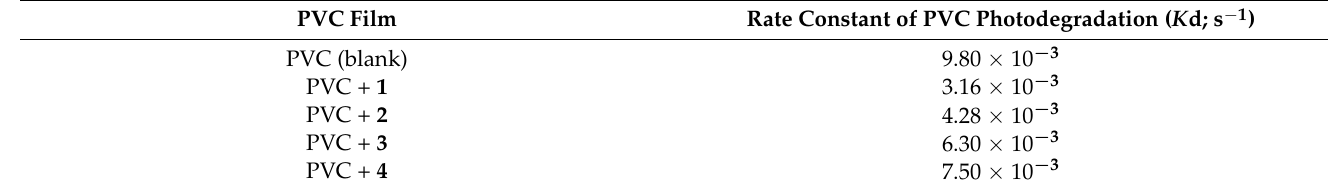
Table 5. Rate constant of photodegradation ( K d) of PVC films.